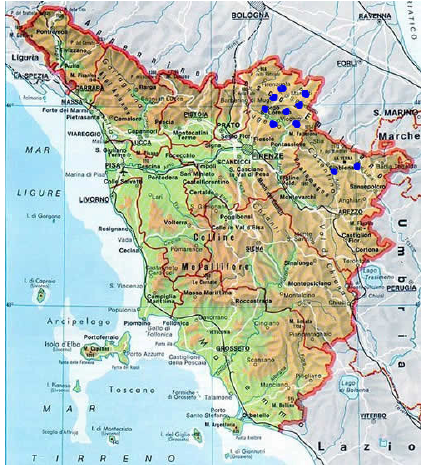
Figure 1. Location of farms.